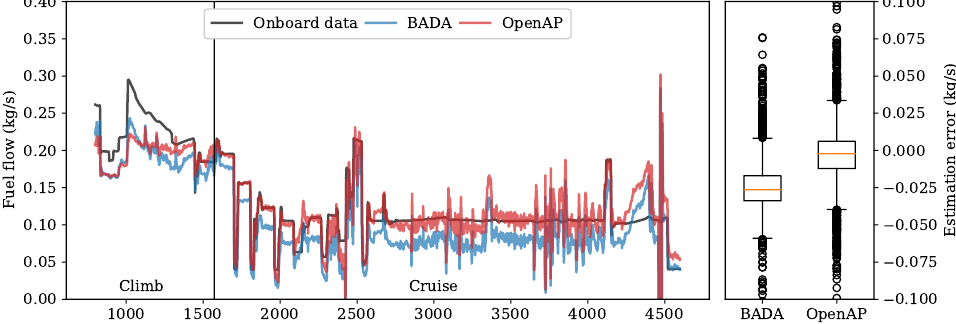
Figure 15. Estimated fuel flow based on the net